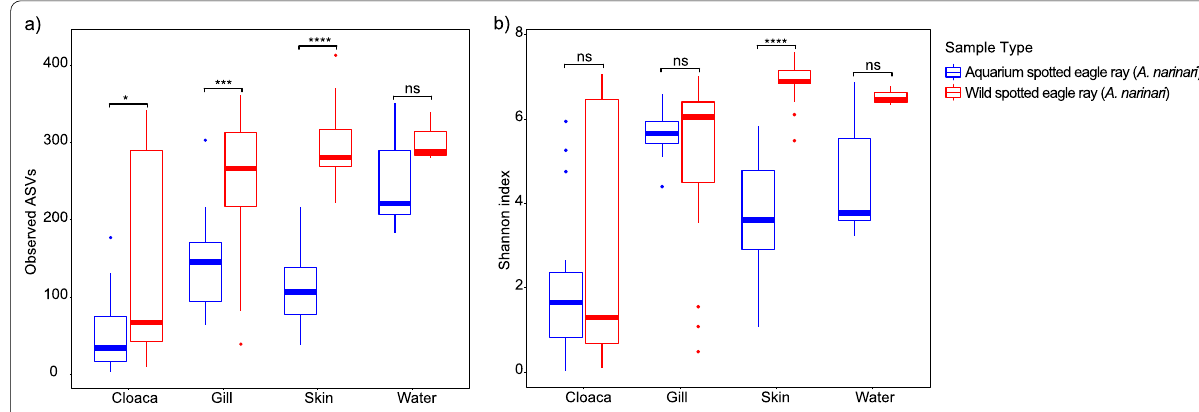
Fig. 2 α‑Diversity metrics for a observed amplicon sequence variants (ASVs), and b Shannon diversity indices, for different body sites (cloaca, gill, and skin) of aquarium and wild whitespotted eagle rays ( Aetobatus narinari ), along with their respective water samples. Aquarium whitespotted eagle rays have lower diversity for all body sites compared to wild whitespotted eagle rays